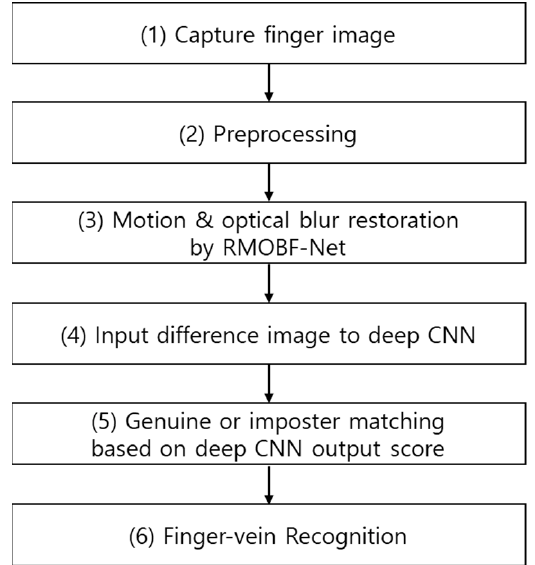
Figure 1. Flowchart of the proposed method.